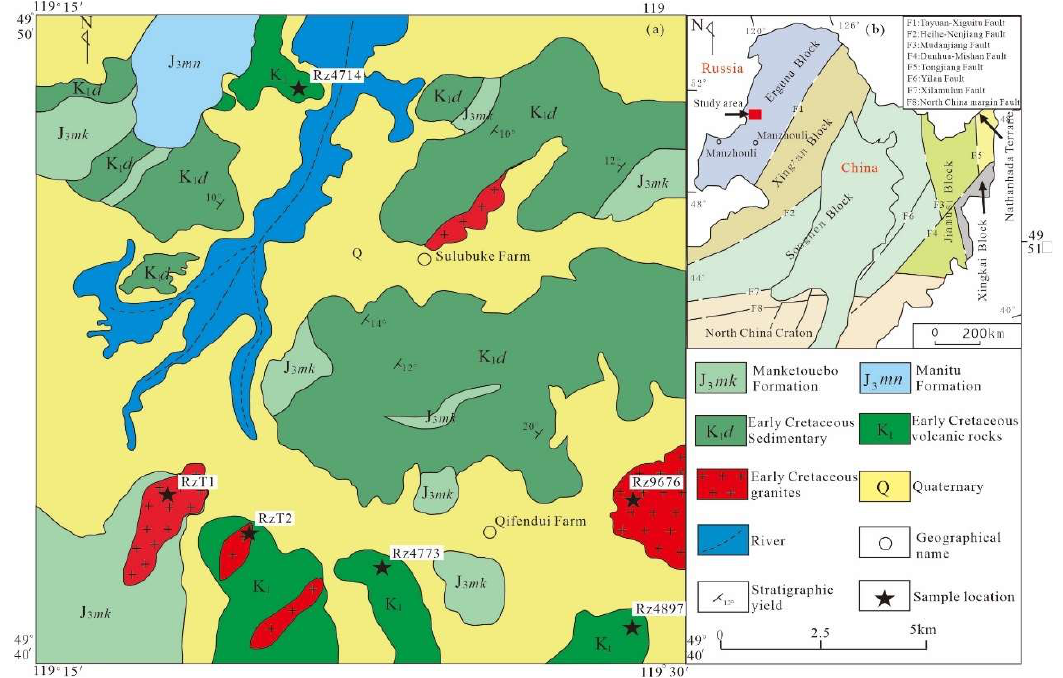
Figure 1. ( a ) A geological sketch map of NE China and ( b ) a geological sketch map of the Badaguan area (modified from Li et al. [7]).